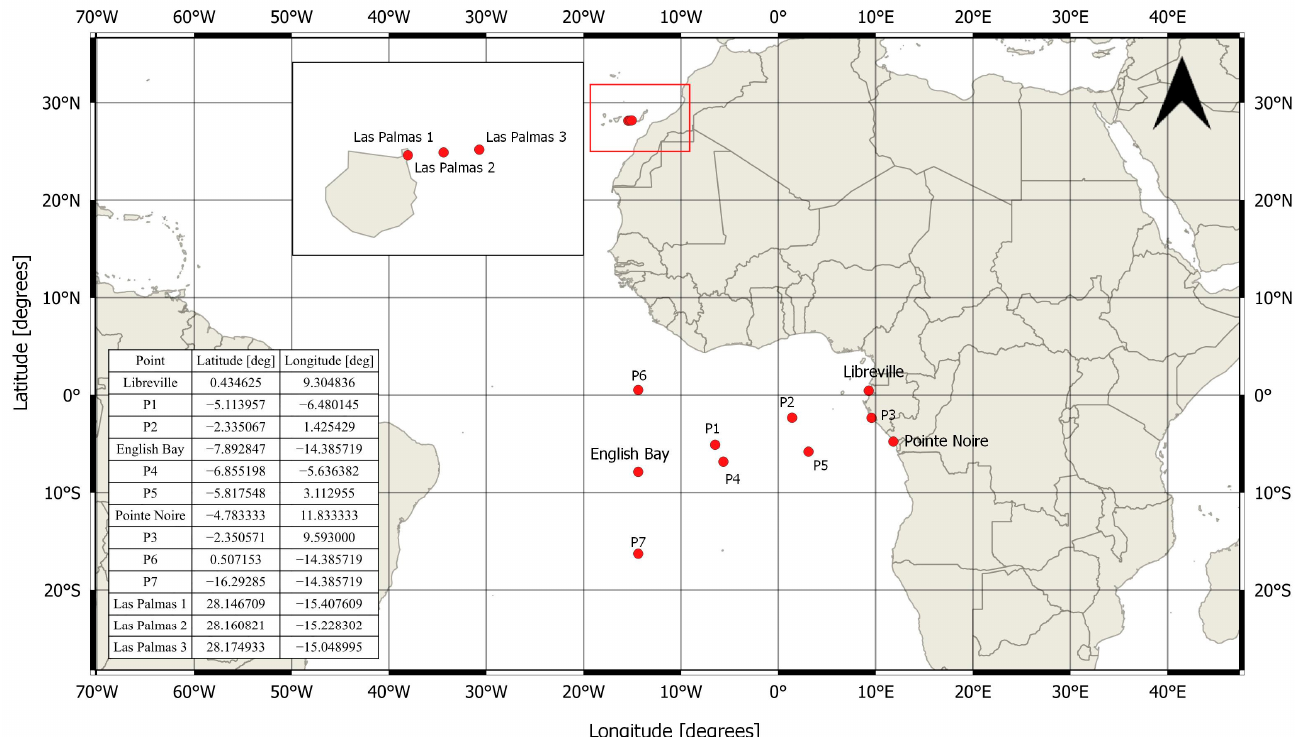
Figure 1. The location of observation points, which were used to determine the relationship between satellite altimetry and bathymetry data.